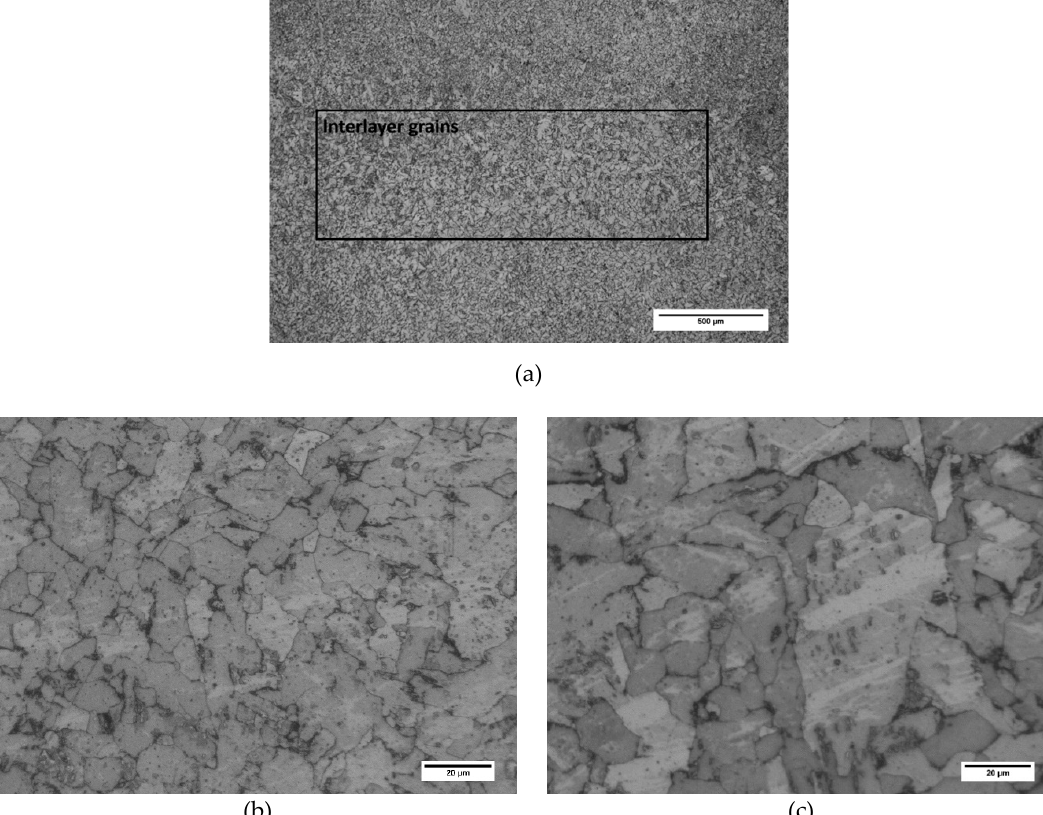
Figure 5. Microstructure attained by an optical microscope. ( a ) Intralayer microstructure with slightly more refined grains. Microstructure with a higher magnification for ( b ) intralayer and ( c ) interlayer grains.